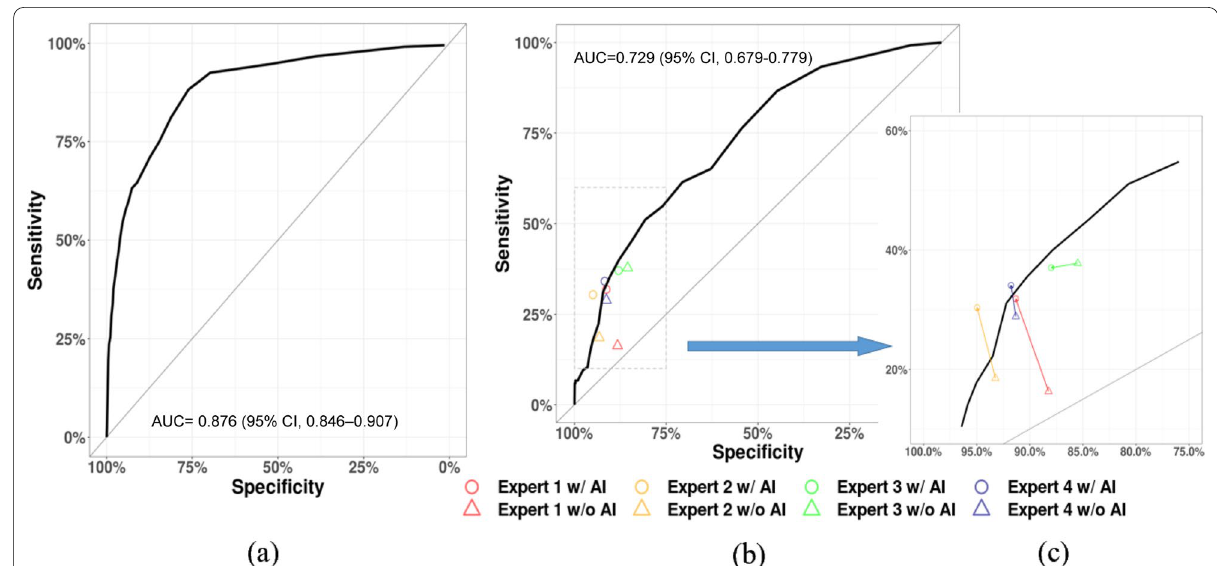
Fig. 4 Performance of the proposed DL-based model. a ROC curve on region-based ASPECTS analysis (20 regions) for the DL-based model on the internal validation set. b ROC curve on region-based ASPECTS analysis for the DL-based model on the external validation set, and the performance of the four raters was also depicted using circle or triangle. c Enlarged illustration of the rater performance in ( b )